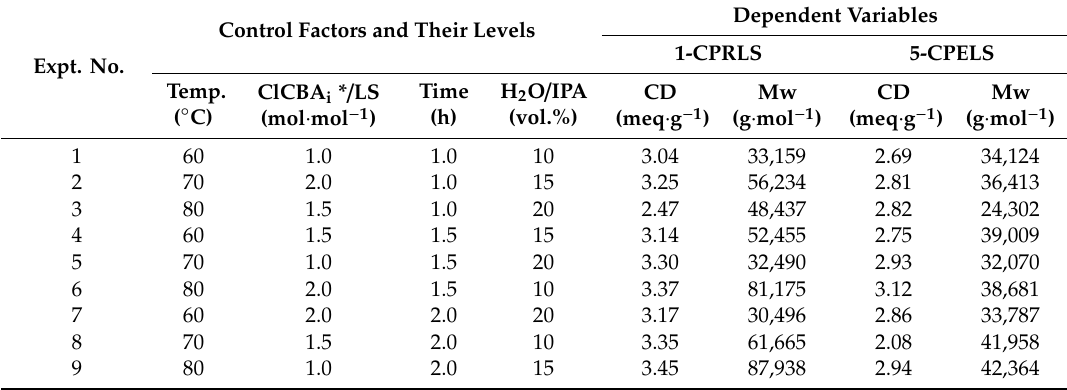
Table 2. Levels and dependent variables for the control factors in the Taguchi orthogonal array (OA) design (L 9